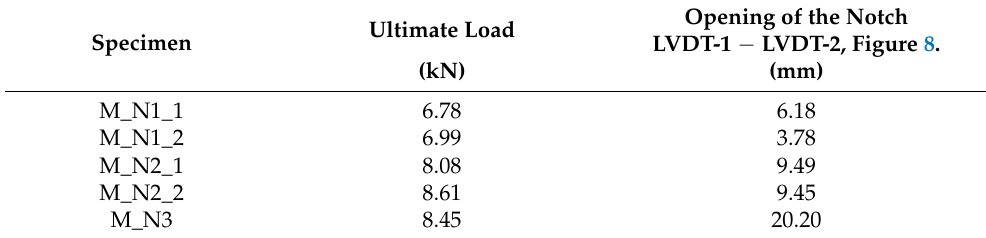
Table 3. Results of the monotonic testing.